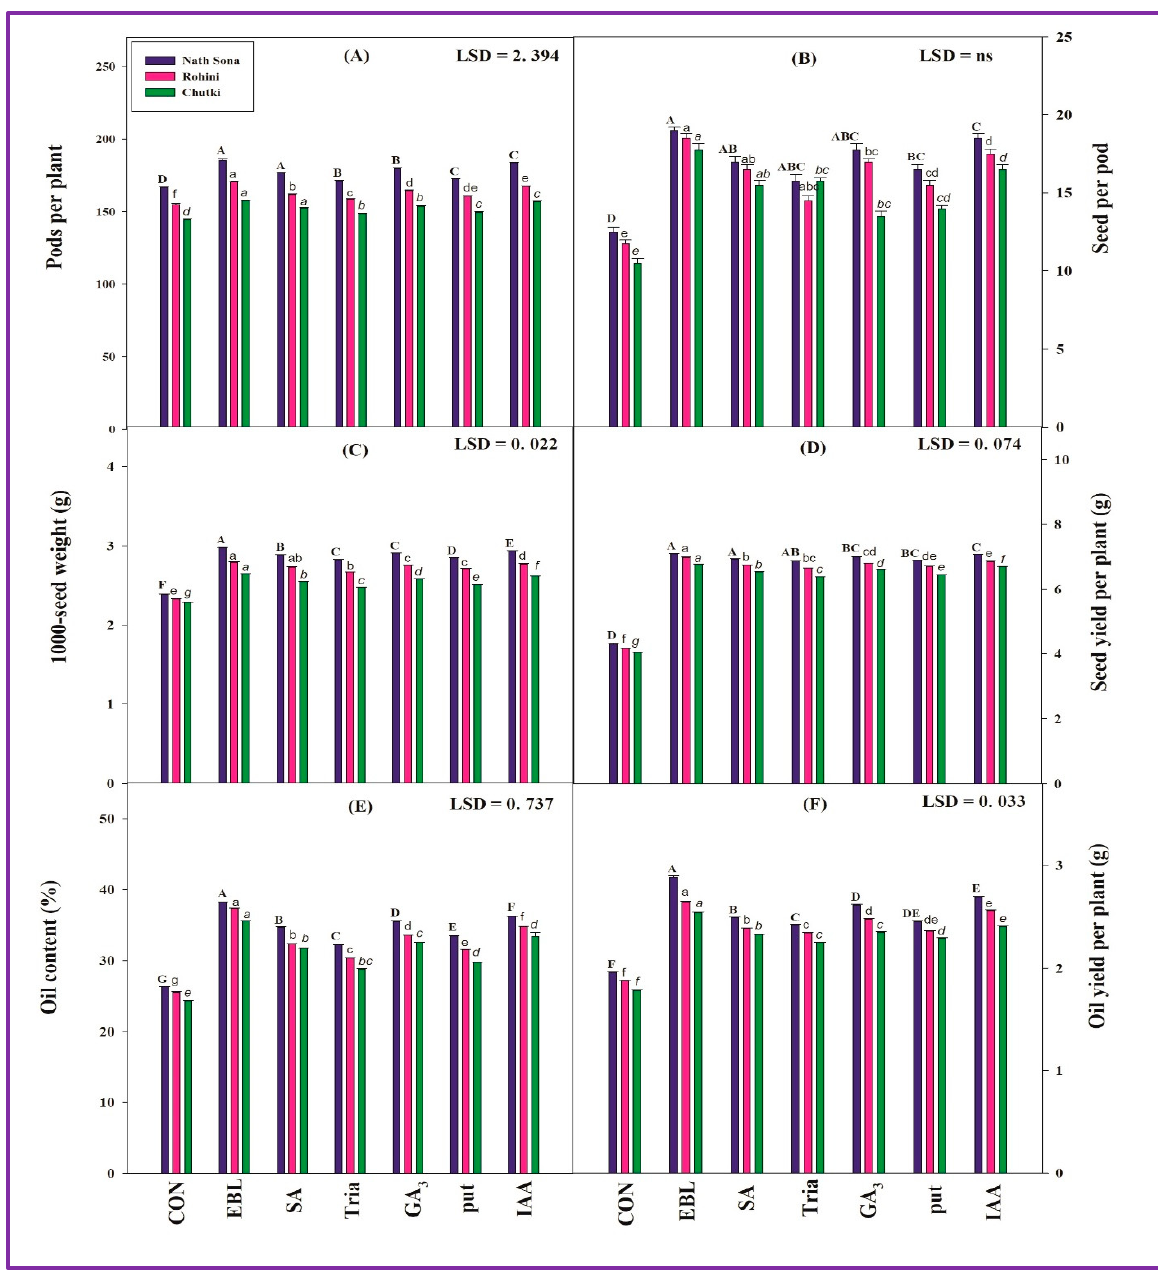
Figure 5. Effect of foliar spray of PGRs on ( A ) Pods per plant, ( B ) Seeds per pod, ( C ) 1000-seed weight, ( D ) Seed yield per plant, ( E ) Oil content, and ( F ) Oil yield per plant of the mustard cultivars Nath Sona, Rohini, and Chutki. Data are treatment means with the standard error (±SE) of four replicates. The different small and capital letters represent a significant difference in three cultivars among various treatments confirmed through Duncan’s Multiple Range test at p ≤ 0.05.